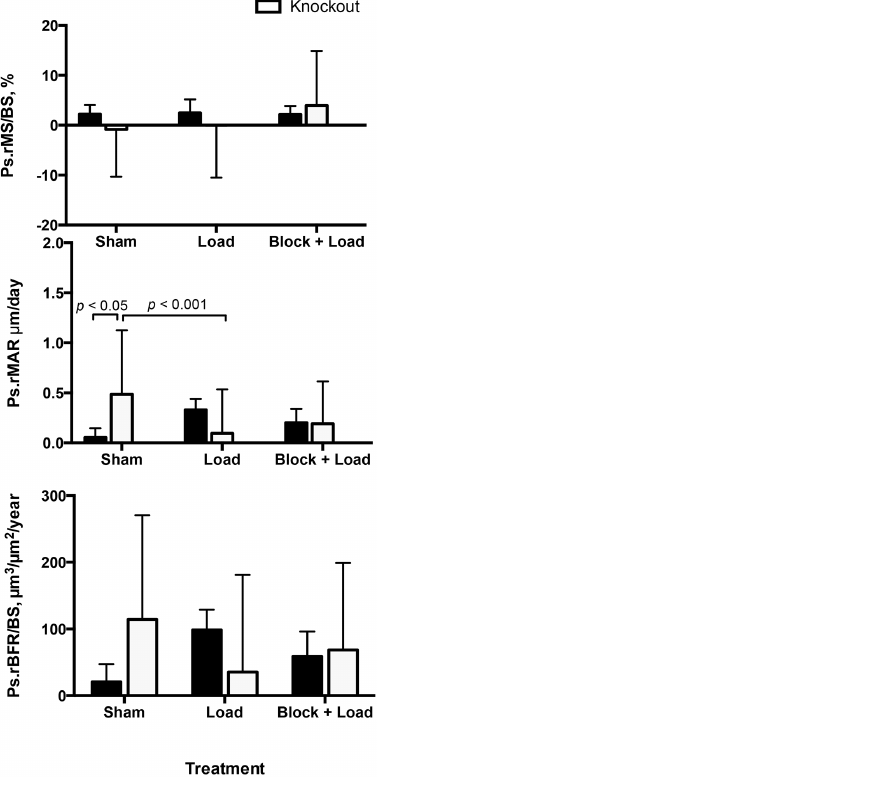
Fig. 6. Adaptive periosteal bone responses in CGRP b were not significantly influenced by mechanical loading treatments. In CGRP b knockout mice, relative periosteal mineral apposition rate (Ps.rMAR) was increased in the Sham group compared with CGRP b wildtype mice. Sham – sham loaded group, Load – loaded group, Block + Load – Brachial plexus anesthesia treatment before loading. n 5 16–20